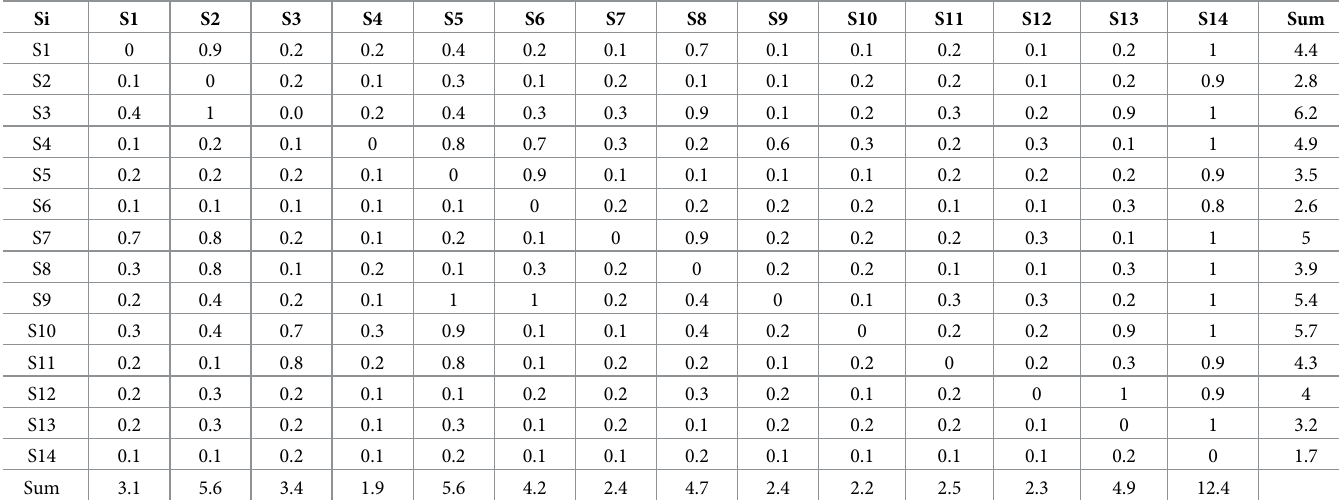
Table 3. The fuzzy direct relation matrix X .